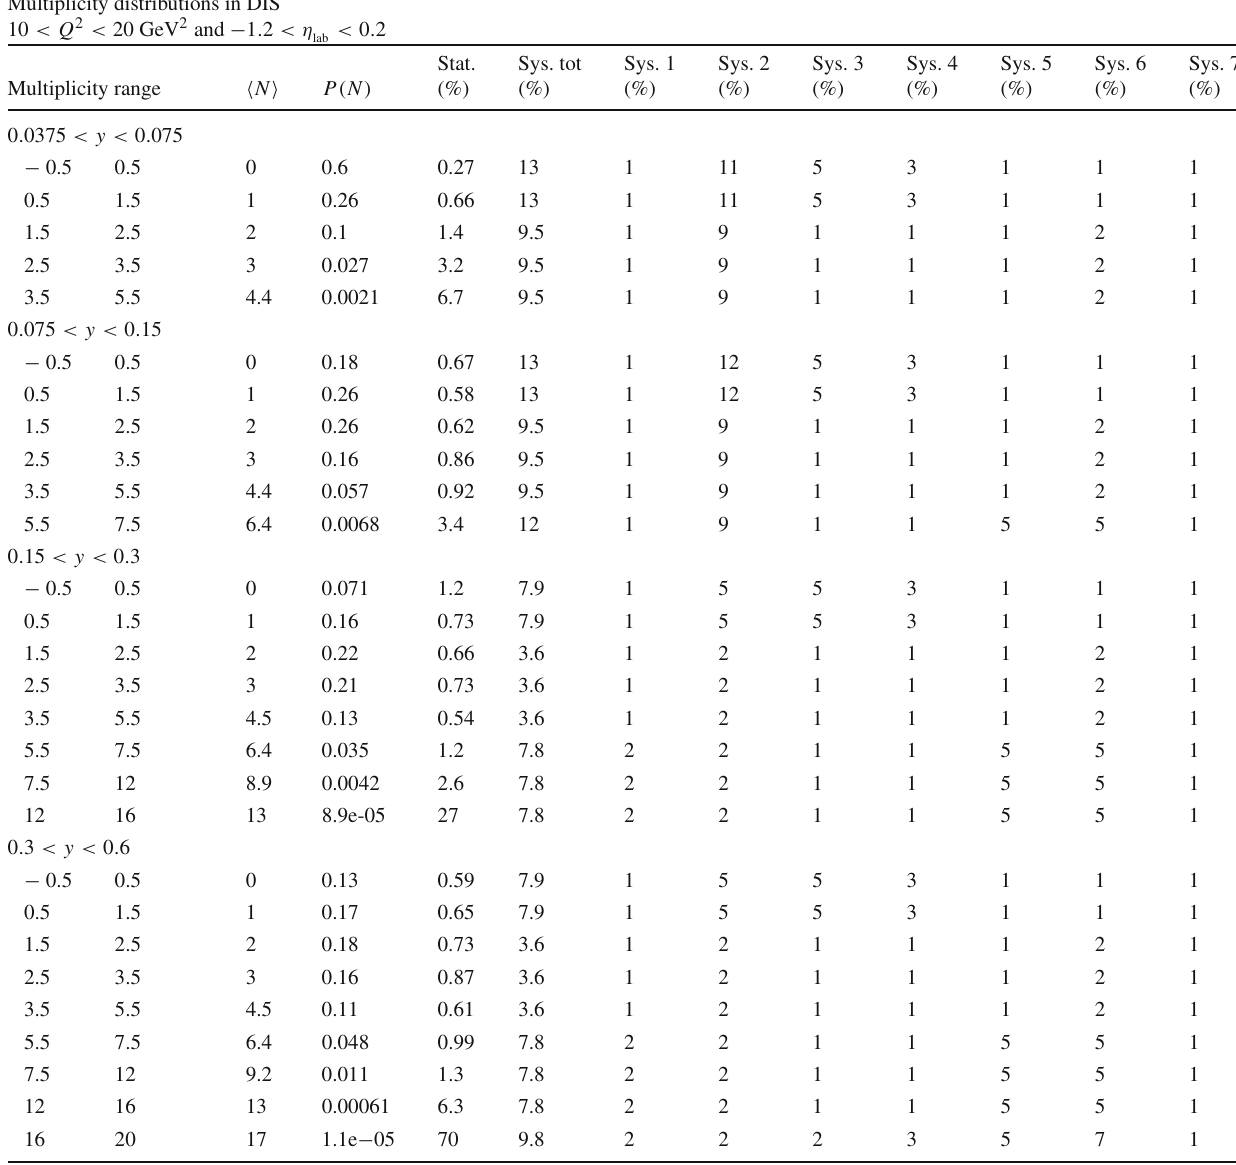
Table 16 Charged particle multiplicity distributions P ( N ) measured √ s = 319GeV with in the ranges of photon virtual- in ep DIS at ity 10 < Q 2 < 20 GeV 2 and charged particle pseudorapidity range Multiplicity distributions in DIS < 0 . 10 < Q 2 < 20 GeV 2 and − 1 . 2 < η lab